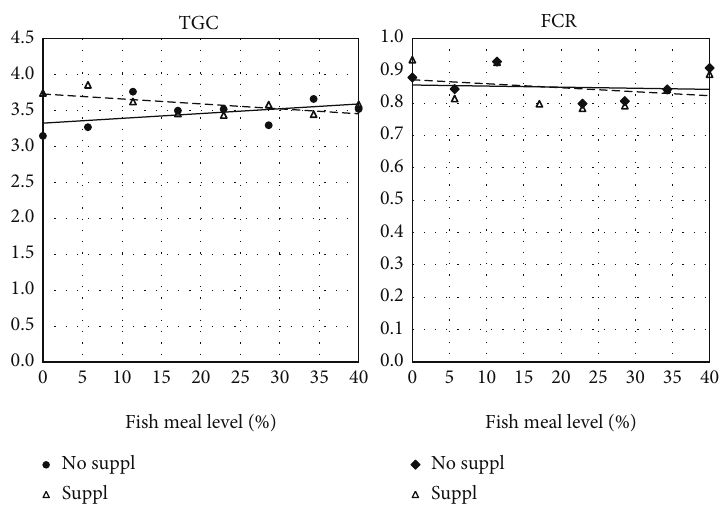
Figure 1: Growth rate as indicated by thermal growth coe ffi cient (TGC) and feed conversion ratio (FCR) in fi sh fed two series of diets varying in fi shmeal level, one series without additional supplement (No suppl) and the other supplemented (Suppl) with a mixture of choline chloride (0.3%), β -glucan (0.05%) and nucleotides (0.05%). For statistics see Table